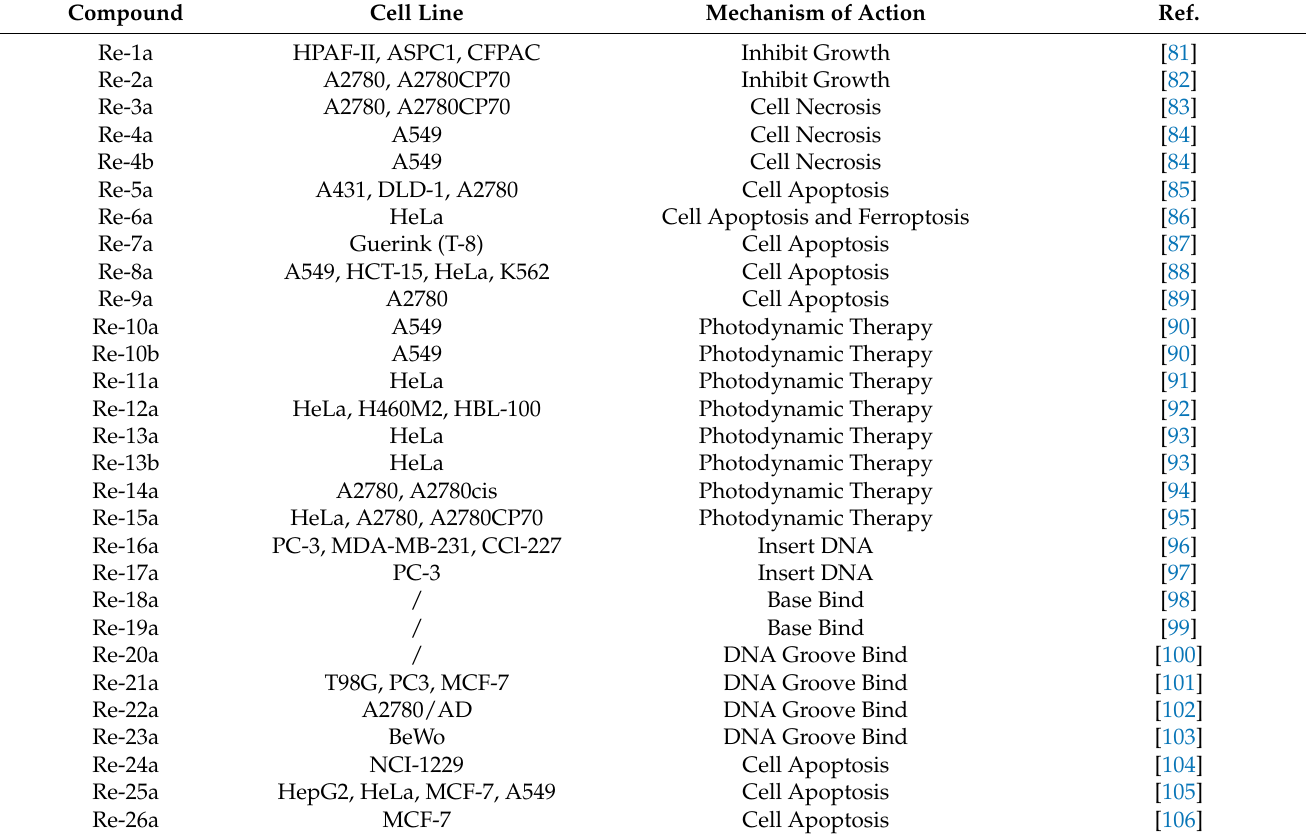
Table 1. Mechanism of action of Re complexes and cancer cell lines they act on. Compound Cell Line Mechanism of